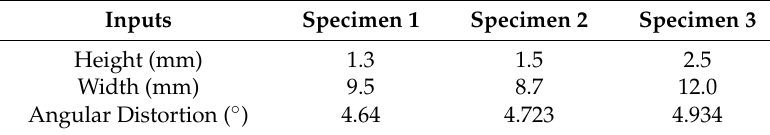
Table 2. Bead dimensions (height and width) and angular distortion of the welded